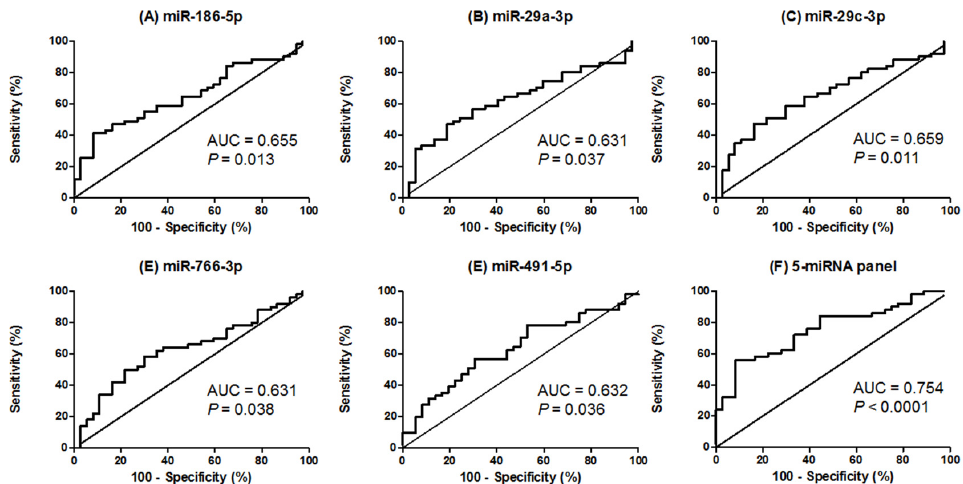
Figure 3. ROC curve analysis using salivary miRNA levels to discriminate CRC patients from healthy individuals. ( A ) Salivary miR-186-5p levels yielded an AUC value of 0.655 (95% CI = 0.5416 to 0.7684); ( B ) Salivary miR-29a-3p levels yielded an AUC value of 0.631 (95% CI = 0.5139 to 0.7474); ( C ) Salivary miR-29c-3p levels yielded an AUC value of 0.659 (95% CI = 0.5452 to 0.7733); ( D ) Salivary miR-766-3p levels yielded an AUC value of 0.631 (95% CI = 0.5132 to 0.7484); ( E ) Salivary miR-491-5p levels yielded an AUC value of 0.632 (95% CI = 0.5150 to 0.7497); ( F ) ROC curve analysis for the combination of the five miRNAs yielded an AUC value of 0.754 (95% CI = 0.6524 to 0.8554). Note: ROC, receiver operating characteristic; CRC, colorectal cancer; AUC, area under the ROC curve; CI, confidence interval; miRNAs, microRNAs.